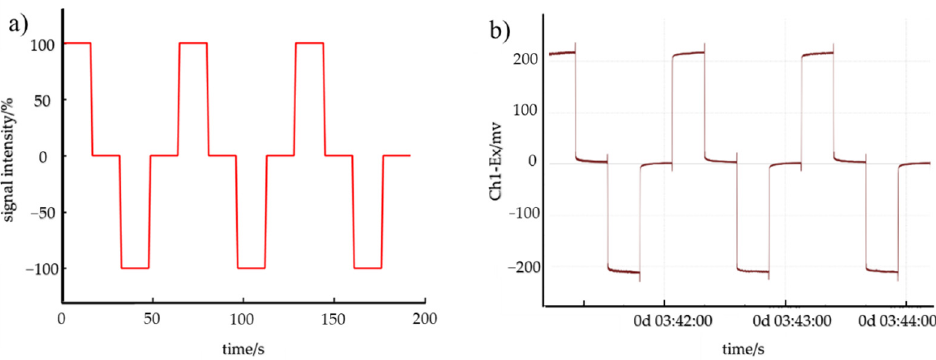
Figure 3. Signal waveform curve. ( a ) Schematic of current signal; ( b ) measured full-waveform sig- nal.